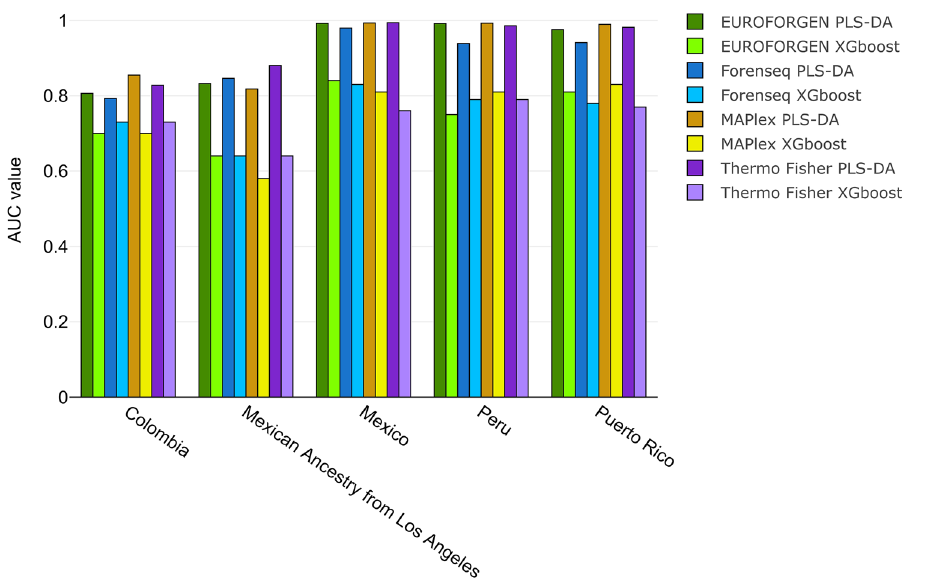
Figure 10. Comparison of AUC values obtained from PLS-DA and XGBoost model for American